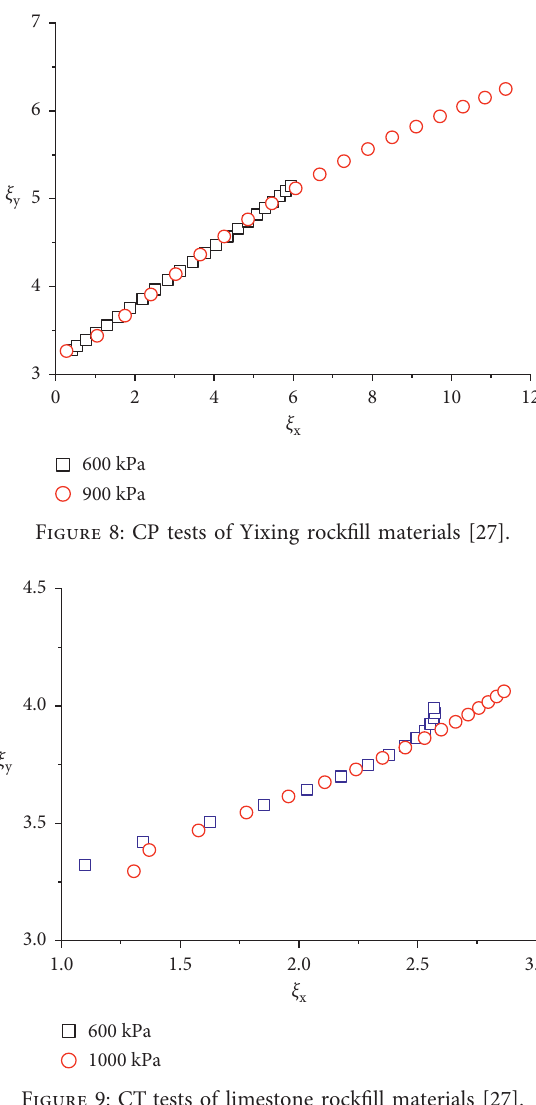
Figure 7: CP tests of granite rockfills [16].